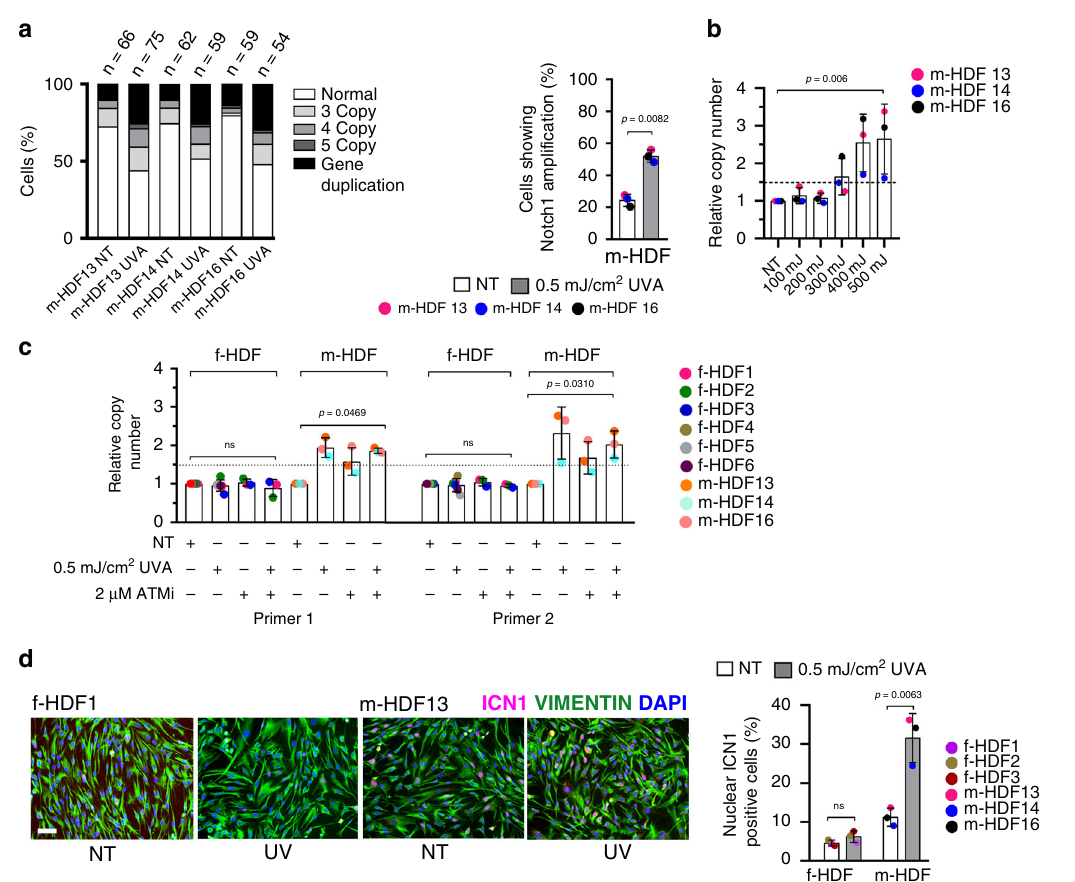
Fig. 4 Expansion of cultured dermal fi broblast populations with NOTCH1 gene ampli fi cation and protein overexpression upon repeated UVA exposure. a Left panel: quanti fi cation of NOTCH1 gene copy number by FISH with a NOTCH1 -speci fi c probe in parallel with a probe for chr9 q21.3 localization in m-HDF strains irradiated with UVA 500 mJ/cm 2 every other day for three times versus mock-treated control (NT). FISH analysis was performed 72 h after the last exposure. The number of analyzed nuclei (n) was obtained from two independent experiments. Right panel: quanti fi cation of the percentage of cells showing NOTCH1 ampli fi cation in m-HDFs plus/minus UVA treatment. Values for each strain are indicated as dots with mean ± s.d. two-tailed unpaired t -test, ** p < 0.001. n (m-HDF strain) = 3. b Quanti fi cation of NOTCH1 gene copy number in m-HDF strains plus/minus repeated UVA treatment (100, 200, 300, 400, and 500 mJ/cm 2 ) versus mock treated control as in a . Primers for NOTCH1 gene were used together with primers speci fi c for the housekeeping gene GAPDH for internal normalization. Values for each strain are indicated as dots with mean ± s.d. One-way ANOVA with Friedman test, ** p < 0.01. n (m-HDF strain) = 3. An additional independent experiment is shown in Supplementary Fig. 3b. c Quanti fi cation of NOTCH1 gene copy number in f-HDF versus m-HDF strains plus/minus chronic UVA exposure as in a . Parallel cultures were also treated with ATM inhibitor (ATMi) KU-60019 (2 µ M) as indicated. Two primers for NOTCH1 gene were used. Relative DNA copies were calculated after GAPDH internal normalization relative to mock-treated control. Values for each strain are indicated as dots with mean ± s.d. One-way ANOVA, * p < 0.05. n (f-HDF strain) = 6, n (m-HDF) = 3. d Representative images and quanti fi cation of immuno fl uorescence analysis of ICN1 expression in f-HDF and m-HDF strains upon chronic UVA treatment as in a versus mock-treated control (NT). Scale bar, 10 μ m. >201 cells were scored per sample. Values for each strain are indicated as dots with mean ± s.d.